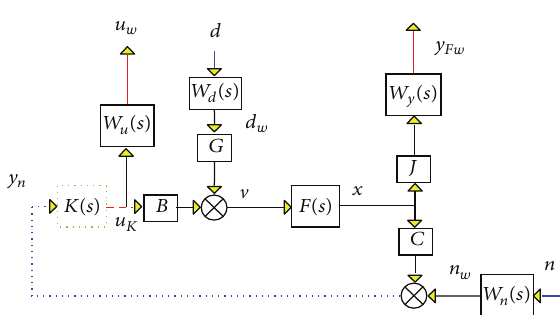
Figure 7: 𝐻 control bloc diagram in the frequency domain. Infinity